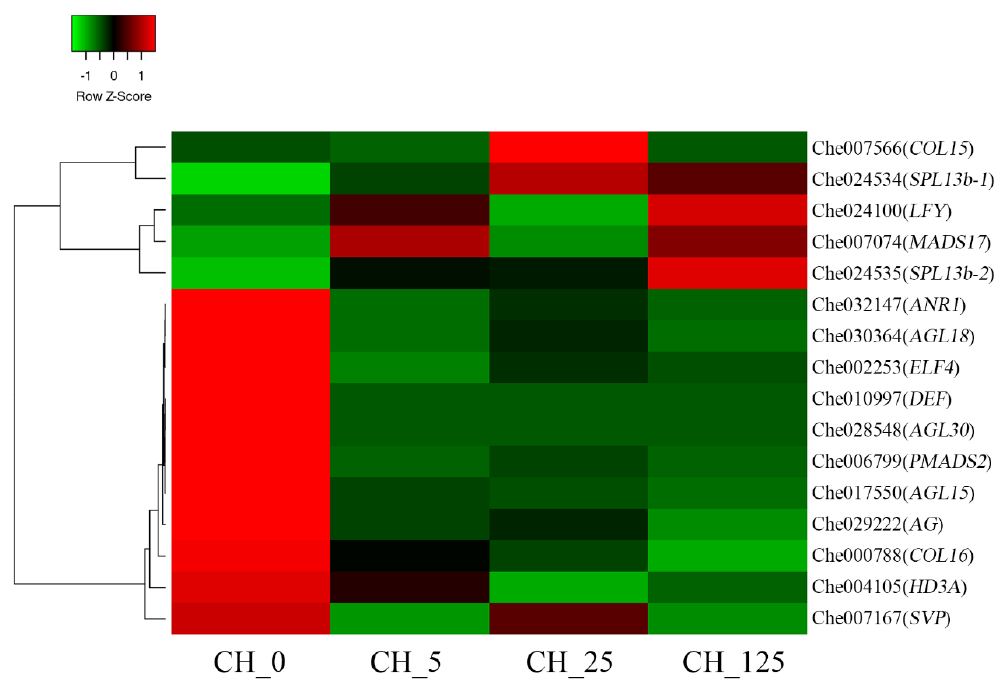
Figure 10. Hierarchical clustering of DEGs involved in the regulation of floral organ and floral development after N-(2-chloro-4-pyridyl)-N’-phenylurea (CPPU) treatment in Castanea henryi.